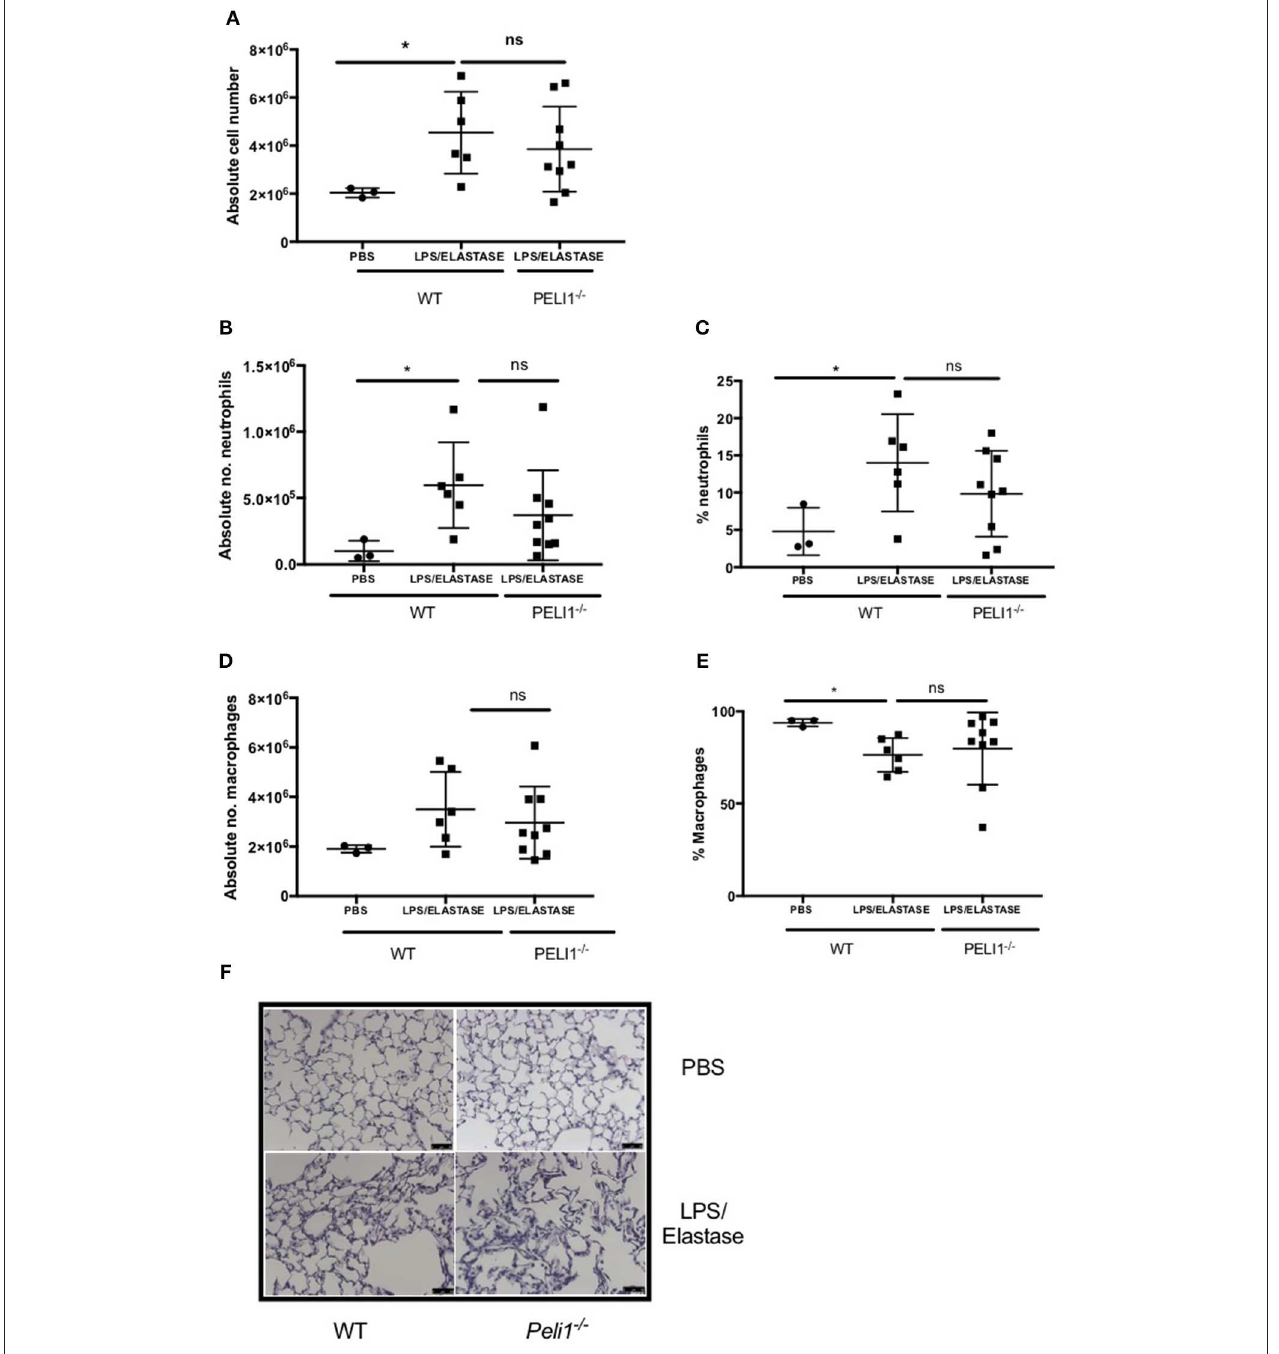
FIGURE 3 | WT and Peli1 − / − mice develop airway inflammation in response to repeated LPS and elastase. Peli1 − / − transgenic mice and WT littermates were given i.n. PBS (black circles) or LPS (7 µ g) and porcine neutrophil elastase (1.2 units, black squares) every 7 days for 4 weeks. Mice were subjected to bronchoalveolar lavage (BAL) on day 28 and inflammation assessed by enumerating total cell number in BALF by haemocytometer (A) and number/proportion of neutrophils (B,C) and macrophages (D,E) by light microscopy. Lungs were removed and stained for histological analysis. Representative images are shown ( F , scale bar = 50 µ m). Individual data points represent a single mouse and panels show mean ± SD. Statistically significant differences are indicated by * p < 0.05 ( n = 3–5 A , n = 3–9 B–E ). Peli1 − / − mice ( Figure 5G). A trend toward fewer viable NTHi concomitantly, the number and proportion of macrophages were was observed in lungs of Peli1 − / − mice compared to WT mice, significantly decreased ( Figures 5E,F ). There was no difference although this did not reach statistical significance, potentially in the rate of neutrophil apoptosis in BALF between WT and